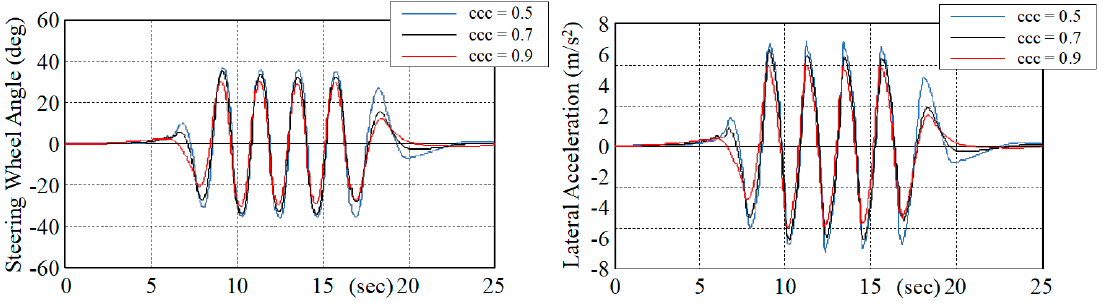
Figure 33. Influence of driver parameter is not significant.